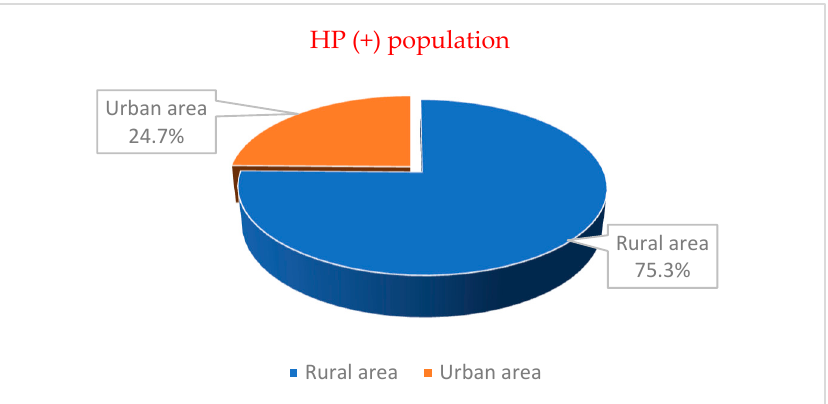
Figure 7. The structure of the group of patients according to the place of living for H. pylori present. Logistic regression was used to characterize the relationship between age, gender and living conditions (stratified as urban/rural area) for pediatric gastritis patients and the probability of testing H. pylori -positive. The most parsimonious model included only age; the results from the model indicate an increased risk of H. pylori infection mirroring the aging process. A more complex model included age and living conditions with a similar log likelihood ratio suggesting an increased risk of H. pylori infection associated with rural living conditions—odds ratio ~2. A summary of the logistic regression results is shown in Table 4. Adding gender to a third model was considered but the result was not statistically significant ( p = 0.34) (Wald). Table 4. Logistic regression model including age, living conditions and H. pylori infection status for pediatric patient with gastritis. B